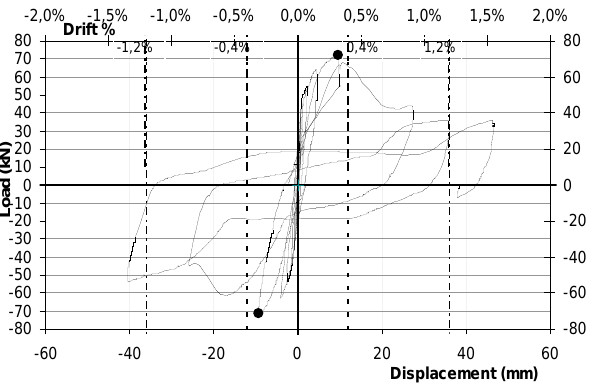
Figure 16 Hysteresis curves of specimen SPS3 Fig. 16. Hysteresis curves of specimen SPS3.